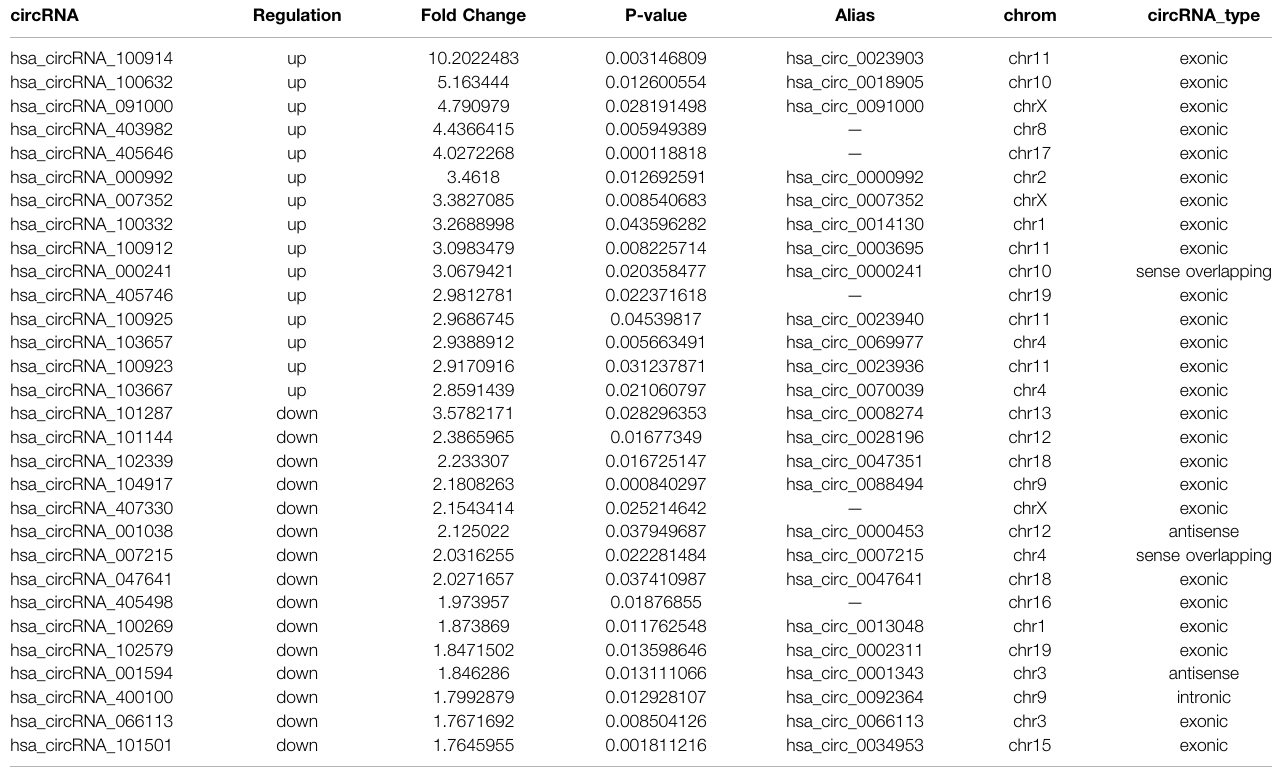
TABLE 2 | The top 15 upregulated and 15 downregulated circRNAs in gout patients compared with healthy control subjects.